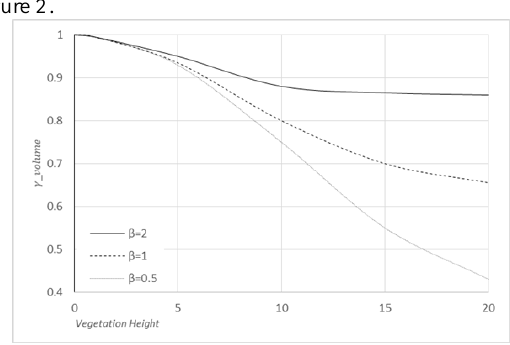
Figure 2 The relationship between volume scattering decorrelation and vegetation height (under different ) Assuming that and , under different sensor parameters, the relationship between volume scatter decorrelation and vegetation height is shown in Figure 3. It can be seen on the above two figures that: 1) With the increase of vegetation height, the volume scattering decorrelation decays continuously, and with the increase of the two-way forest transmissivity ( ), the decay rate of volume scattering decorrelation decreases; 2) In the same two-way forest transmissivity, the L-band sensor (ALOS-2) has the lowest sensitivity to vegetation height, followed by the C-band sensor (Sentinel-1), and the X-band sensors (COSMO-SkyMed Figure 1 The relationship between surface scattering and TerraSAR-X) are most sensitive. This result shows that the decorrelation and slope angle wavelength is dominant in the volume scattering decorrelation compared to other sensor